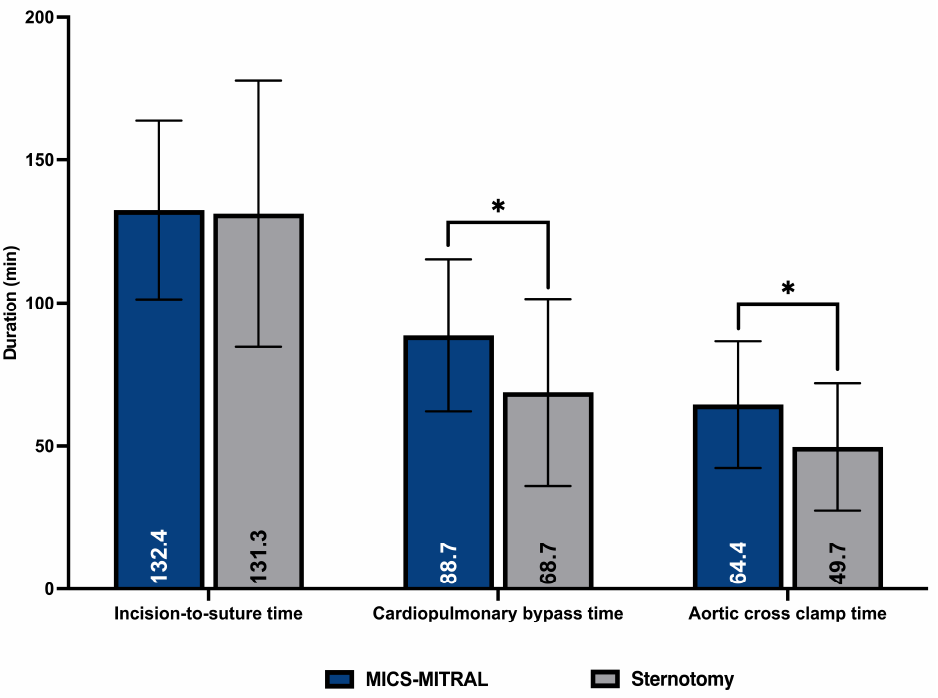
Figure 3. Procedural times comparing MICS-MITRAL and Sternotomy. Note: *, p < 0.05. Table 4. Data of surgical procedures performed on the mitral valve.